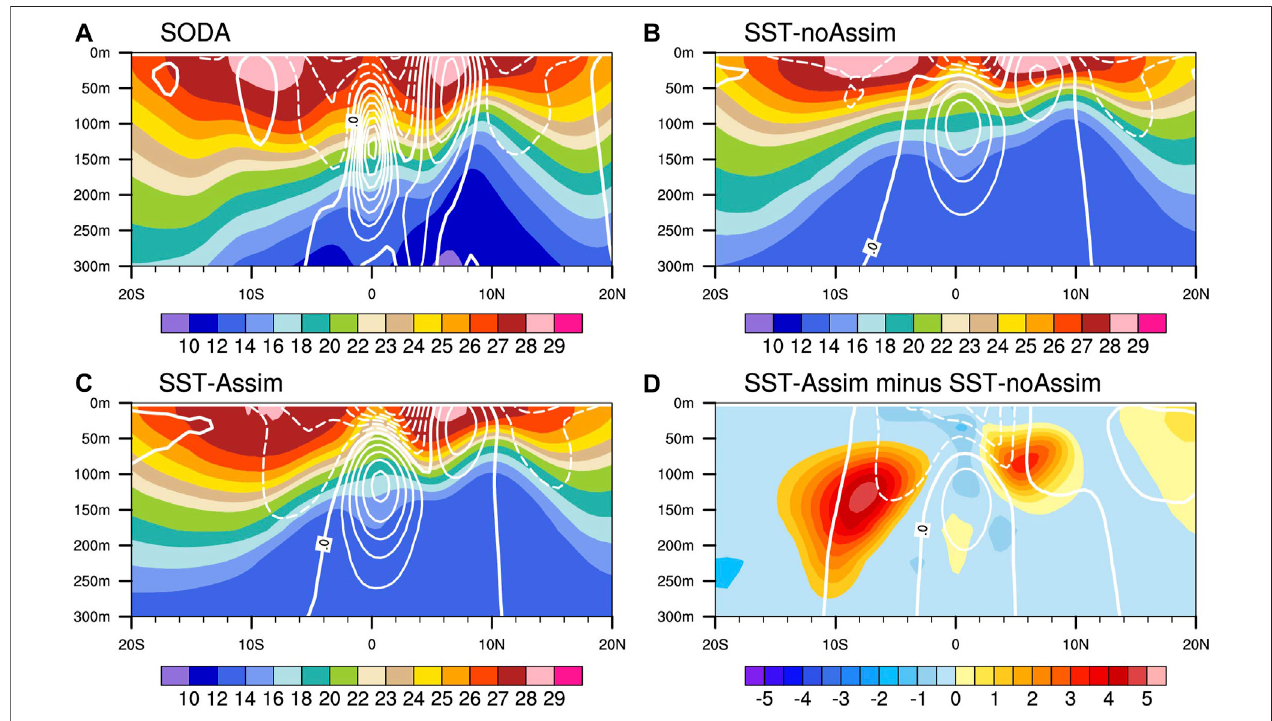
FIGURE 5 | Latitude – depth diagram of annual mean oceanic temperature (shaded, in ° C) and zonal current (white contours, eastward in solid and westward in dashed lines), averaged over 160 ° E — 110 ° W for (A) the reanalysis data SODA, (B) SST-noAssim experiment and (C) SST-Assim experiment, respectively; (D) The difference between SST-Assim experiment and SST-noAssim experiment (SST-Assim minus SST-noAssim). The average period of SODA (temp and U) is from 1982 to 2013. The average period of the model data is from 1982 to 2014.